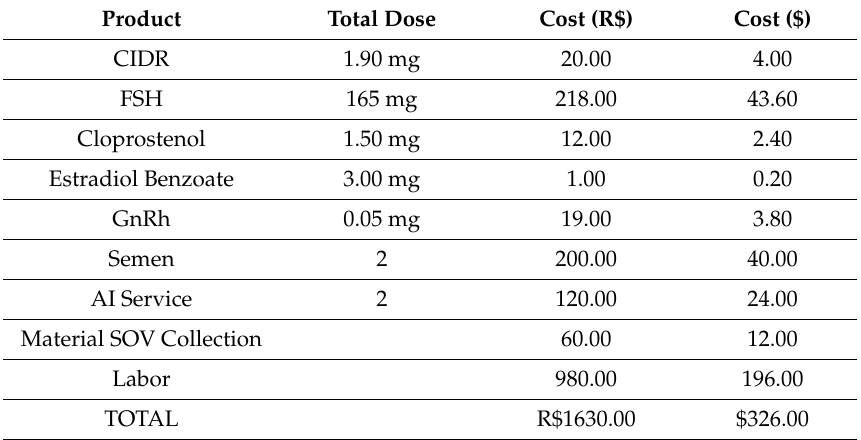
Table 1. Total cost for embryo production and collection using the superovulation protocol (SOV)